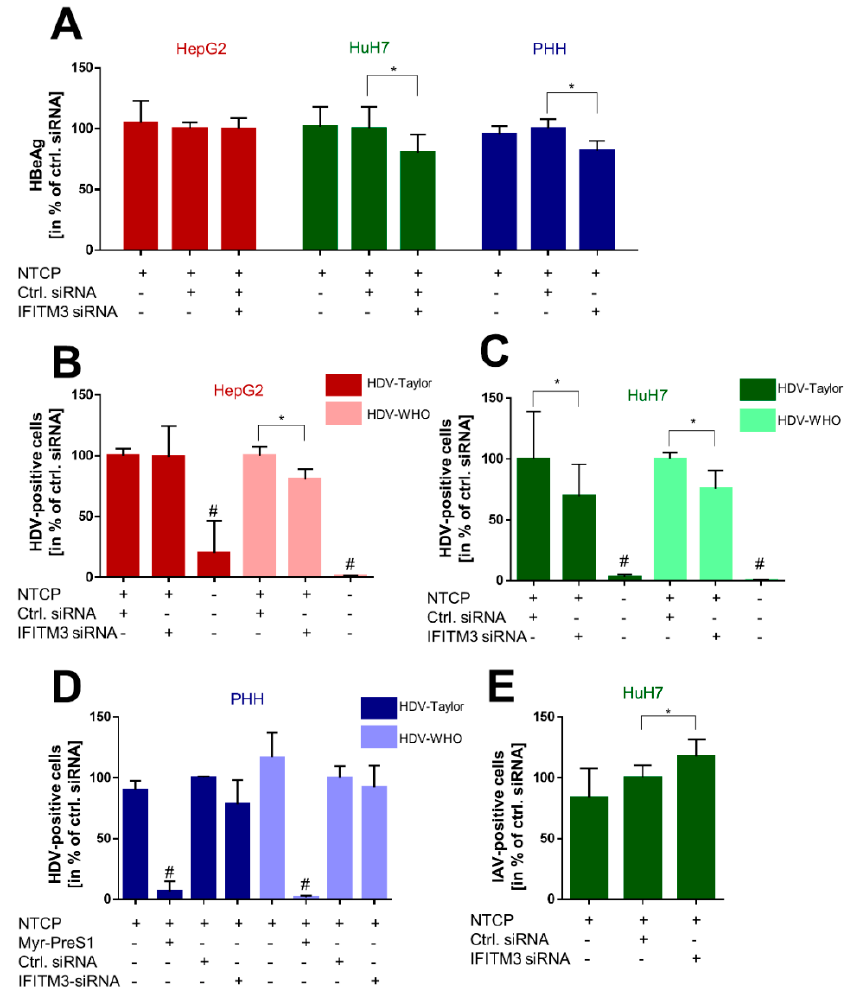
Figure 4. Effect of IFITM3 knockdown on the HBV/HDV receptor function of NTCP. PHH, HepG2, and HuH7 cells were seeded on 24-well plates, transfected with either control or IFITM3-siRNA, and incubated for 72 h (HepG2/HuH7) or 48 h (PHH). ( A ) Cells were inoculated with 5 × 10 9 HBV genomes/well overnight prior to medium changes every second day until collection of supernatants on day 10 post-infection and quantification of secreted HBeAg using the HBeAg Architect assay. Data represent means ± SD of combined data from three independent experiments each with triplicate or quadruplicate determinations. * Significantly lower after IFITM3 siRNA transfection compared to control siRNA with p < 0.05 according to two-way ANOVA with Sidak multiple comparisons test. ( B – D ) Cells were inoculated with 2–4 × 10 5 HDV IU/well overnight prior to medium changes every 2–3 days until fixation and immunostaining with human anti-HDV-positive serum on day 8 post-infection. Quantification of infected cells was performed using an automated imaging. Data represent means ± SD of combined data from three independent experiments each with triplicate determinations ( B , C ) or from two independent experiments with duplicate determinations ( D ).